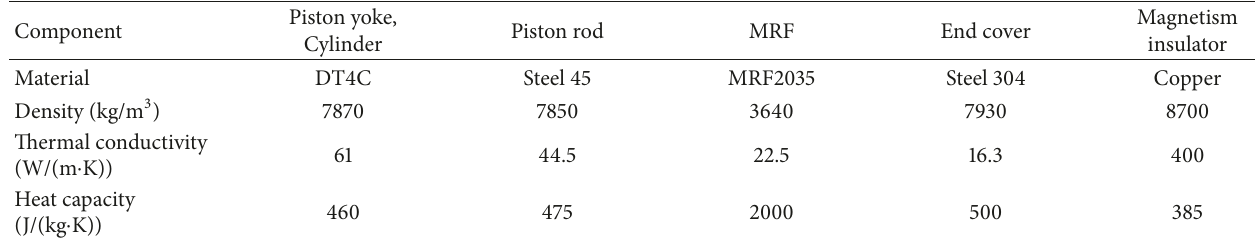
Table 1: Material properties of the MRF